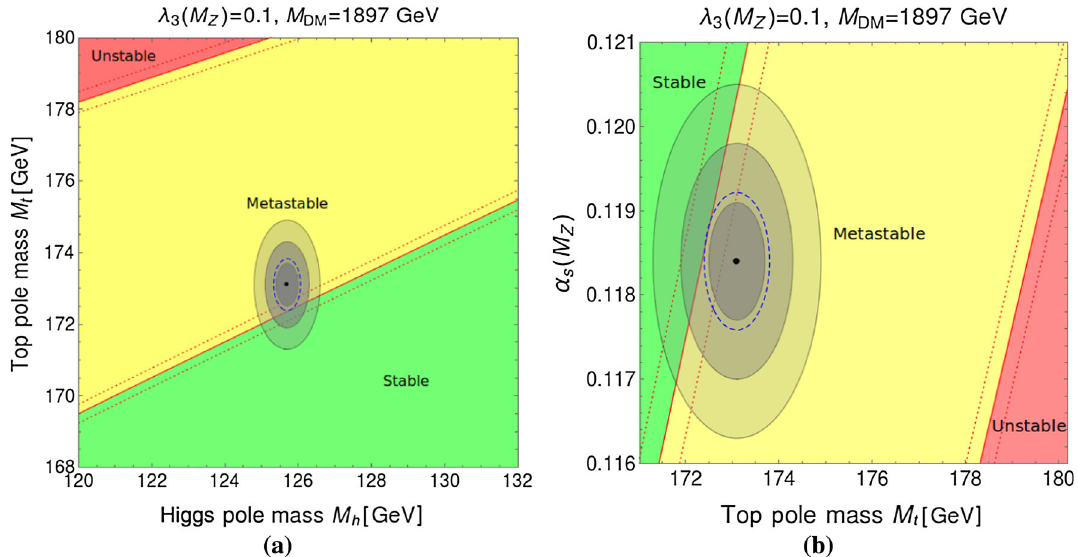
Fig. 5 Phase diagrams in a the M h – M t plane and b the M t – α s ( M Z ) planeITM.Regionsofabsolutestability(green),metastability(yellow), instability(red) of the EW vacuum are alsomarked. The gray zones rep-